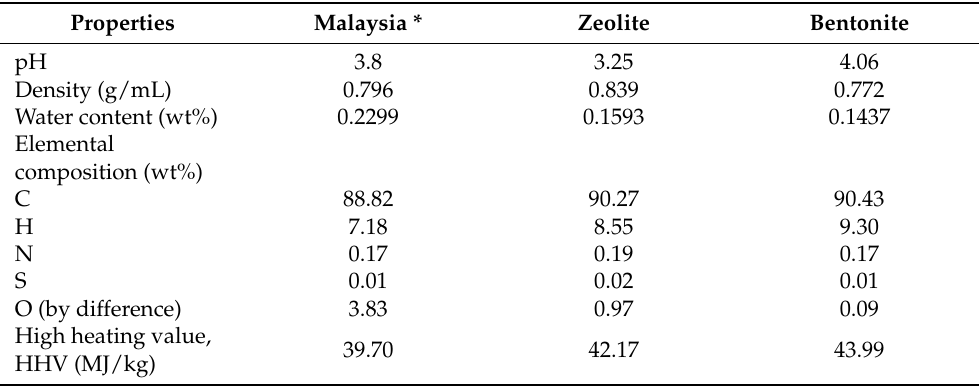
Table 3. The properties of pyrolysis oil using 1 g of